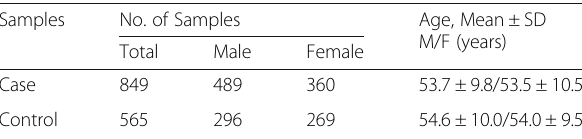
Table 1 Characteristics of Kashin-Beck disease patients and controls Samples